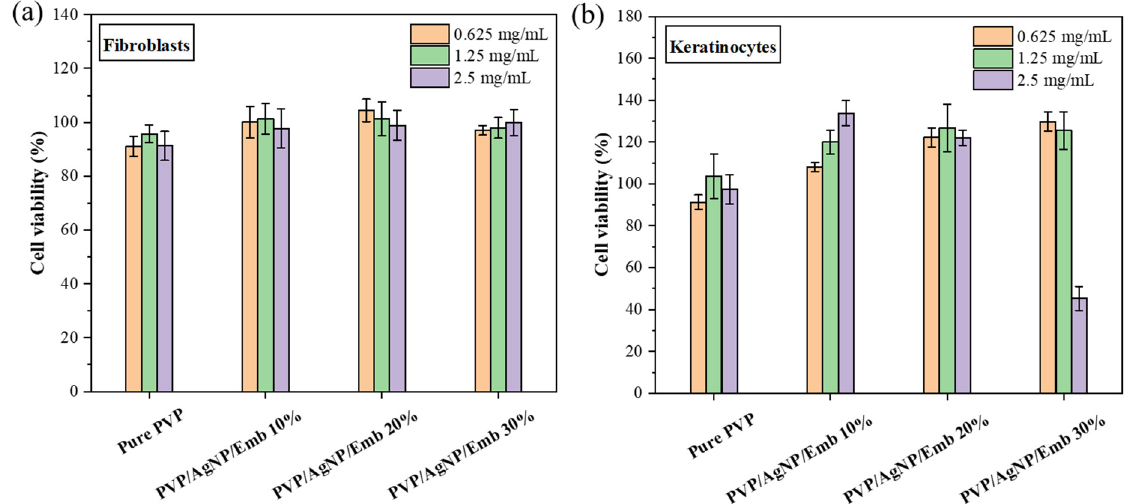
tested cells was measured (Figure 10).